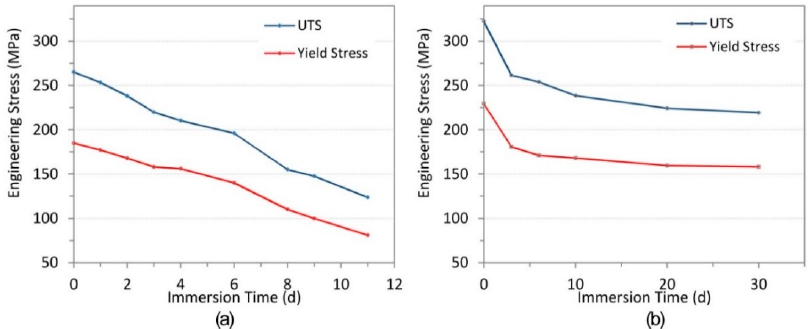
Figure 3. Mechanical properties (UTS and yield stress) of ( a ) dog-bone and ( b ) wire specimens over time. Error bars omitted for clarity (n = 3)